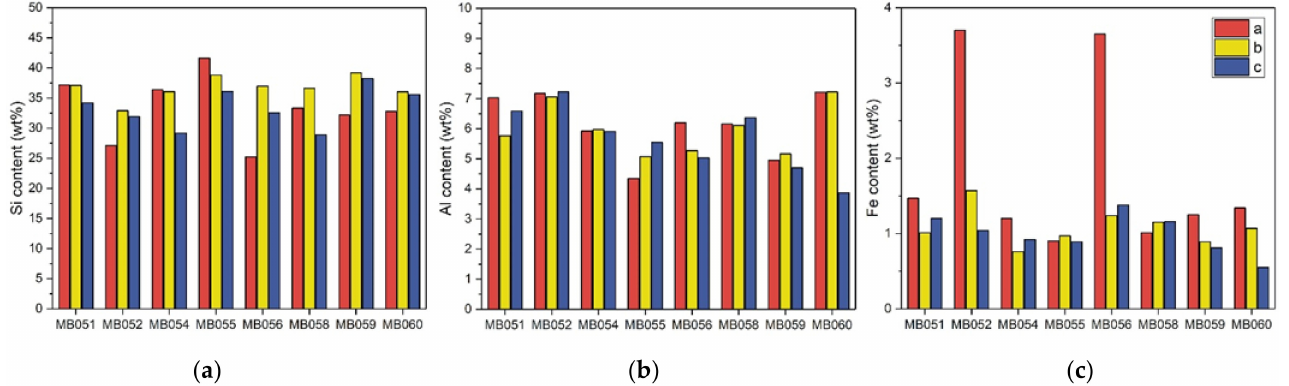
Figure 5. Contents of characteristic elements of Si, Al, and Fe in ( a ) outer, ( b ) core, and ( c ) inner layers of Ban Muang Bua potsherd